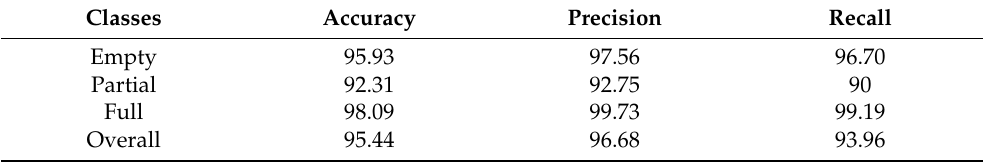
Table 8. Performance metrics of the proposed model on the various states of the smart bin.